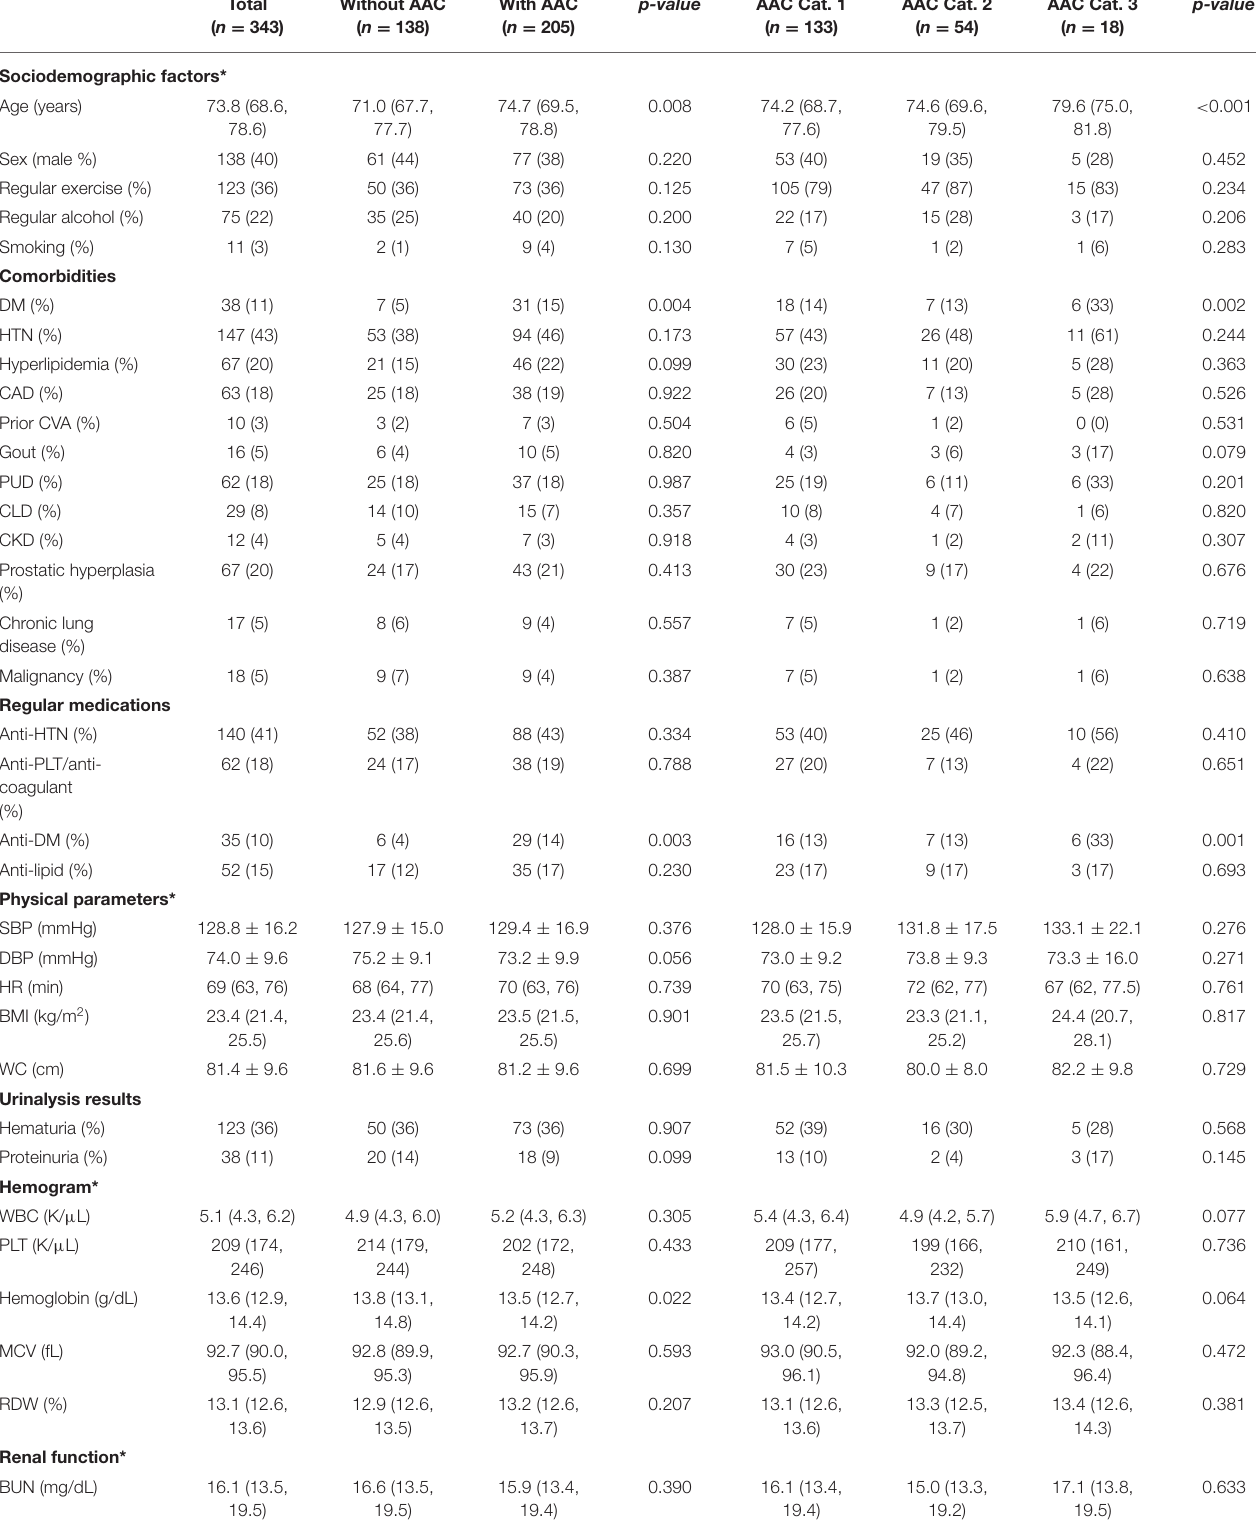
TABLE 1 | Comparison of features between community-dwelling older adults with and without different AAC